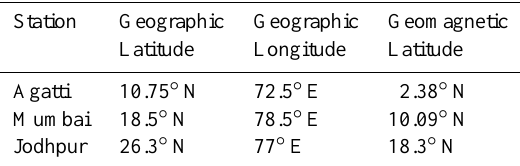
Table 1. List of stations considered for the present